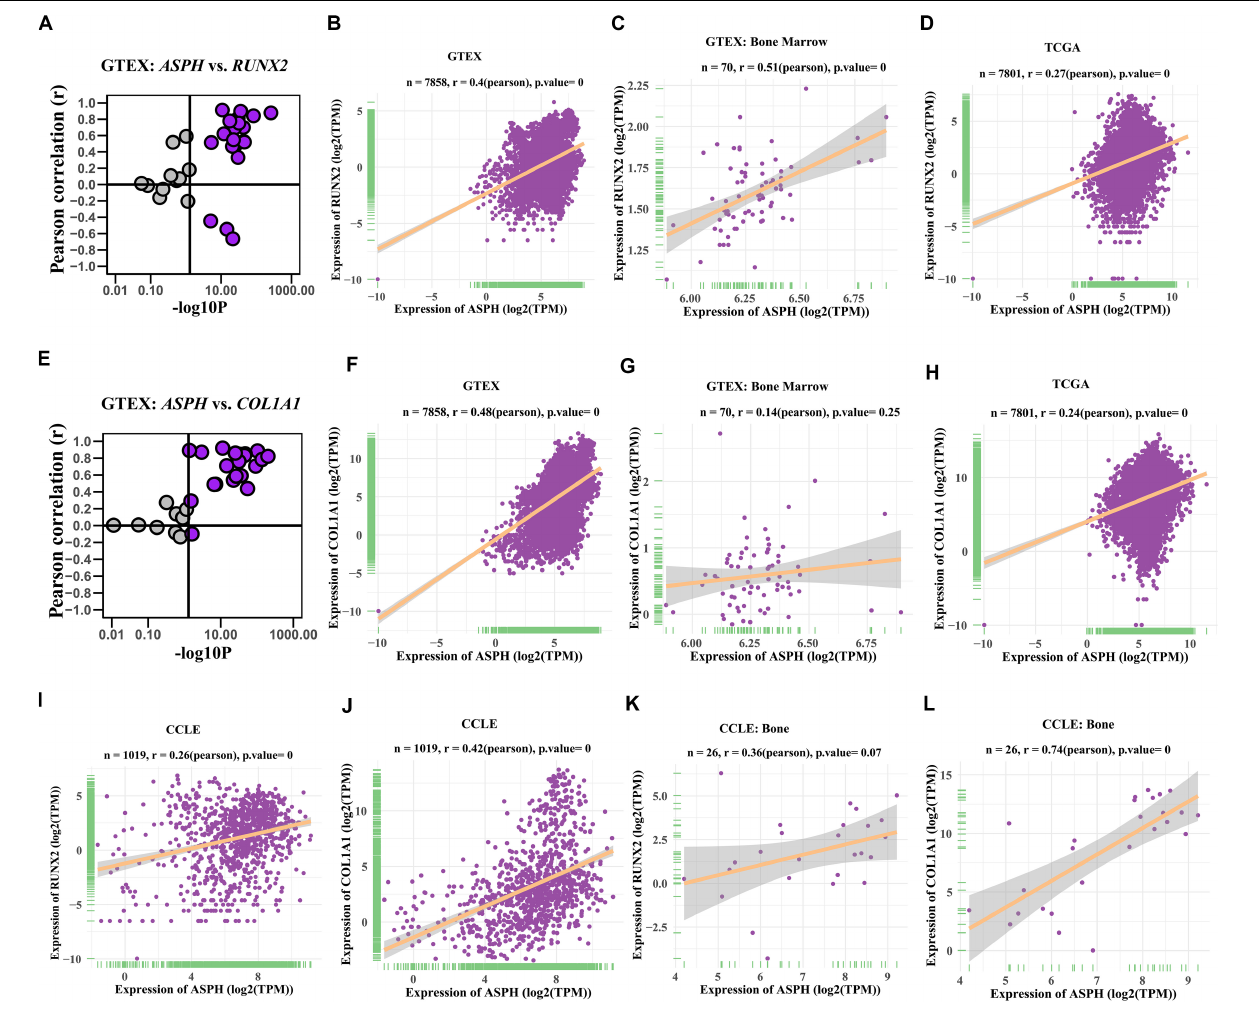
FIGURE 2 | Co-expression of ASPH with osteogenic markers. (A–D) Correlation of ASPH with RUNX2 in expression in normal tissues (A,B) , bone marrow from normal tissues (C) , and cancer samples (D) , based on the data from Genotype Tissue Expression (GTEx) and The Cancer Genome Atlas (TCGA) databases, respectively. (E–H) Correlation of ASPH with COL1A1 in expression in normal tissues (E,F) , bone marrow from normal tissues (G) and cancer samples (H) , based on the data from GTEx and databases, respectively. (I,J) Correlation of ASPH with RUNX2 in expression in cancer cell lines (I) and in bone related cancer cell lines (J) , based on the data from Cancer Cell Line Encyclopedia (CCLE). (K,L) Correlation of ASPH with COL1A1 in expression in cancer cell lines (K) and in bone related cancer cell lines (L) , based on the data from CCLE. The correlation coefficient (r) and P -value were calculated by Pearson’s Correlation analysis. Note that every